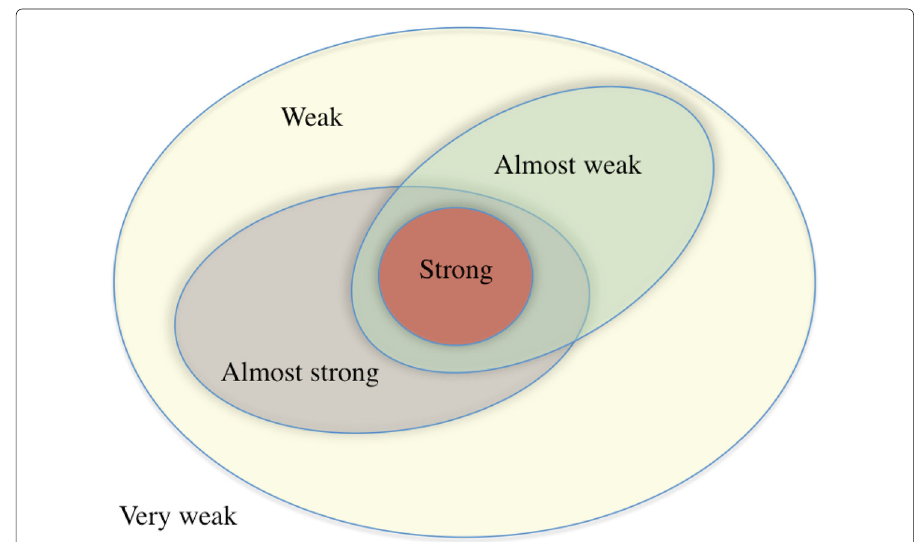
Fig. 1 Relationships between the 5 categories of community strength